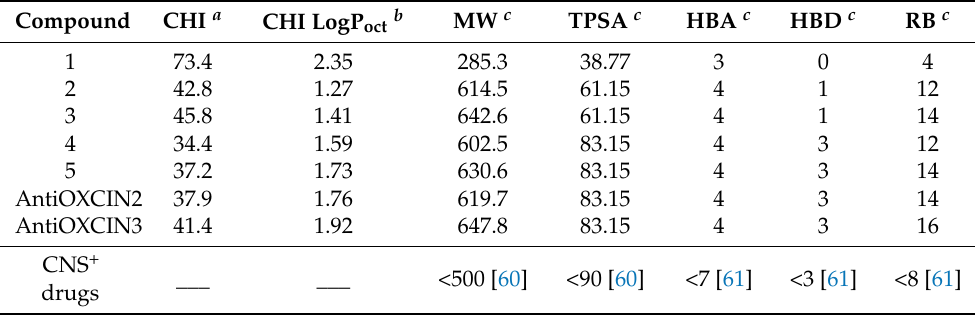
Table 5. Calculated CHI and CHI Log P oct and predicted drug-like properties of piperine (compound 1) and TPP + conjugates 2–5, AntiOXCIN2 and